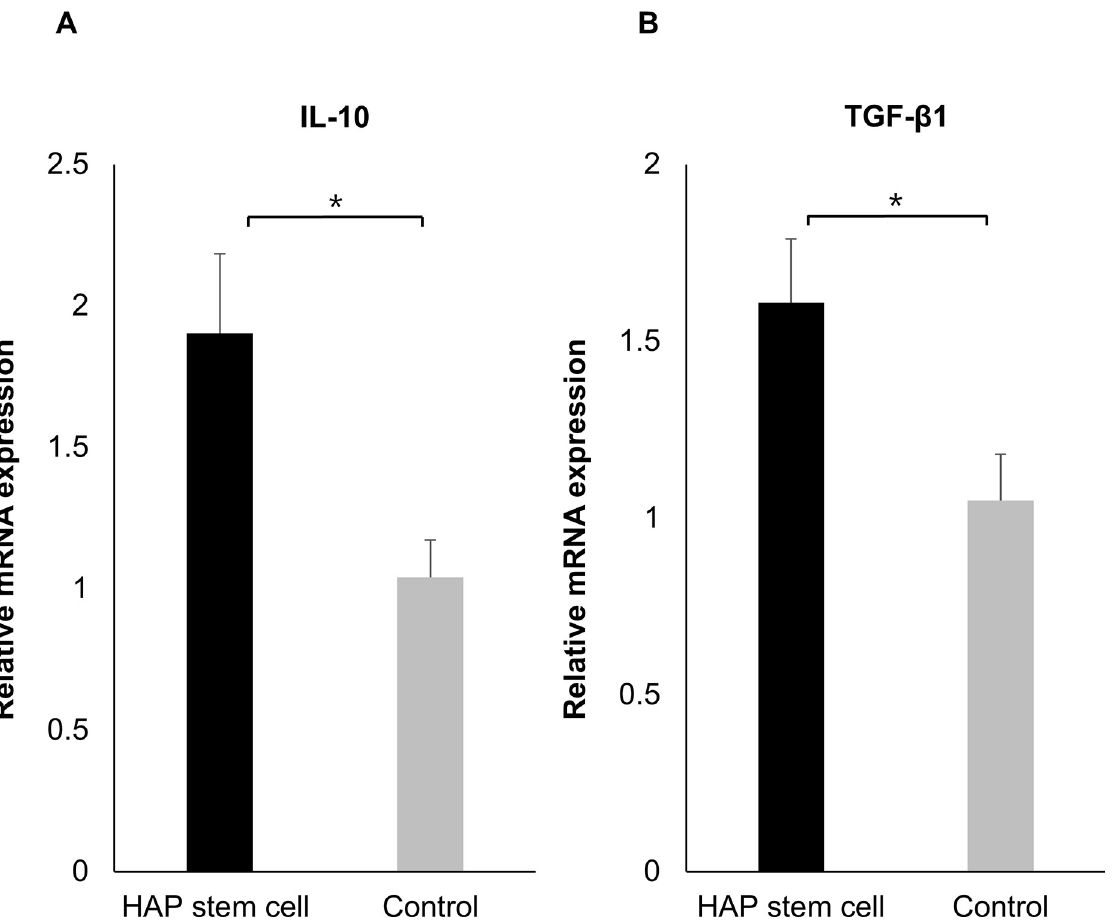
implanted control mice (HAP-stem-cell-implanted mice: n = 12; non-implanted control mice: n = 6). � P < 0.05. (B) The TGF- β 1 expression level of the brain in C57BL/6J mice was increased in the HAP-stem-cell-implanted mice compared to the non-implanted control mice (HAP-stem-cell-implanted mice: n = 12; non-implanted control mice: n = 8). � P <